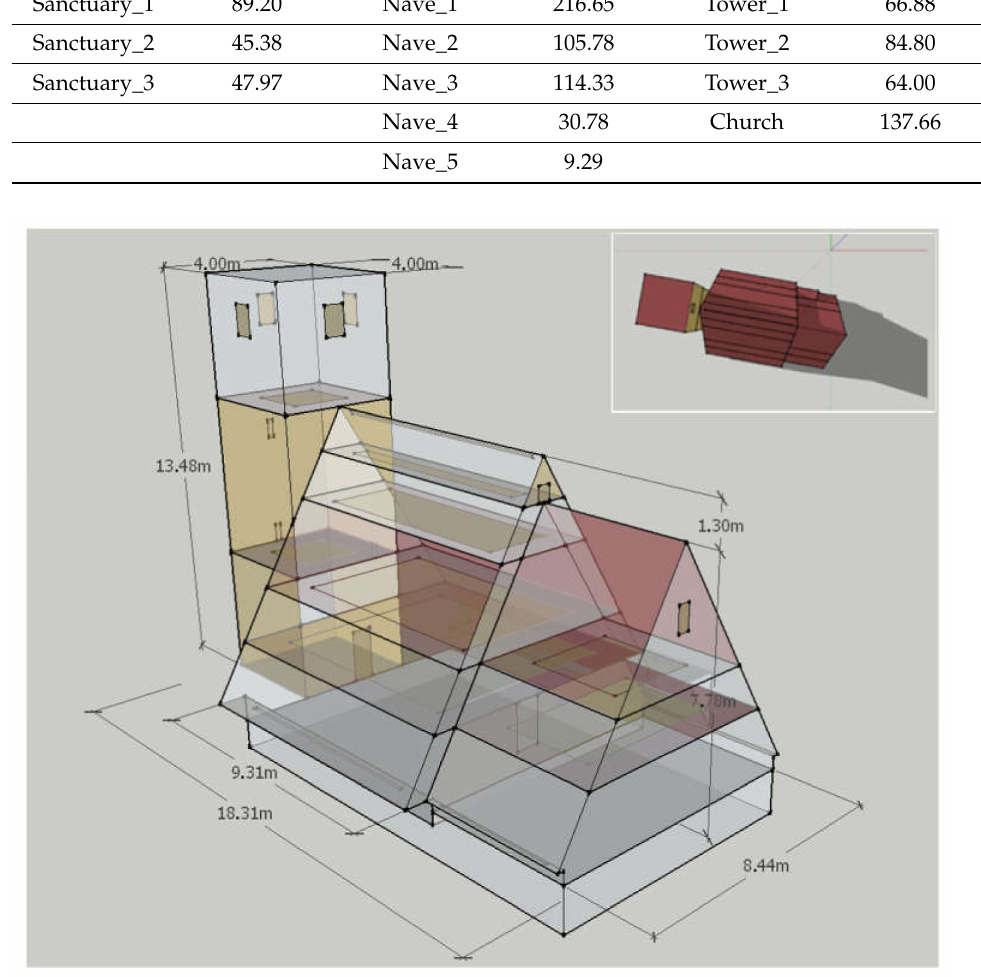
Figure 4. Side view of the BPS model with dimensions (a top view with the cast shadow on 6.6. at 6:00 p.m. in right-top